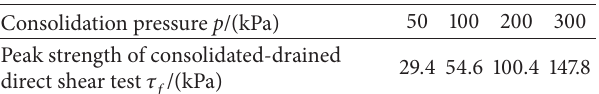
Figure 1: Schematic diagram of shear box. (1) Vertical displacement meter; (2) upper box; (3) permeable stone; (4) lower box; (5) cover plate for loading; (6) specimen; (7) compression framework; (8) horizontal displacement meter; (9) pulley; and (10) weight. Table 1: Peak strength of consolidated-drained direct shear test under different consolidation